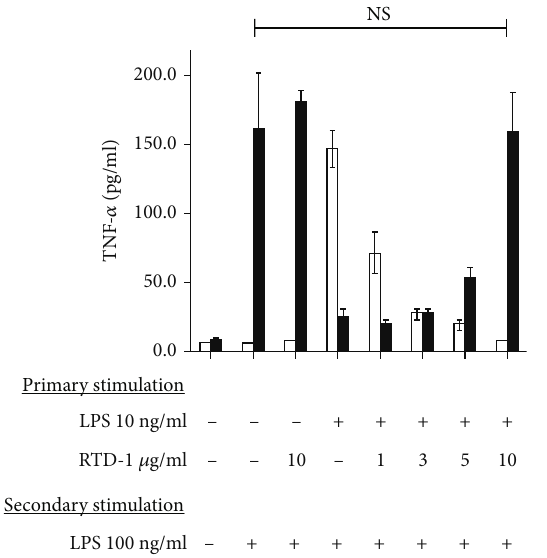
Figure 5: RTD-1 inhibits endotoxin tolerance by regulating NF- κ B activity. THP-1 Dual cells were treated with 10 ng/ml LPS, LPS +10 μ g/ml RTD-1, or PBS for 18h. The cells were washed and restimulated with vehicle control or 100 ng/ml LPS for ~ 22h. Supernatant SEAP activity was measured by the QUANTI-Blue assay and the fold change between LPS and vehicle-treated secondary stimulation from 3 experiments was plotted. ∗ P < 0 : 05 one-tailed, paired t